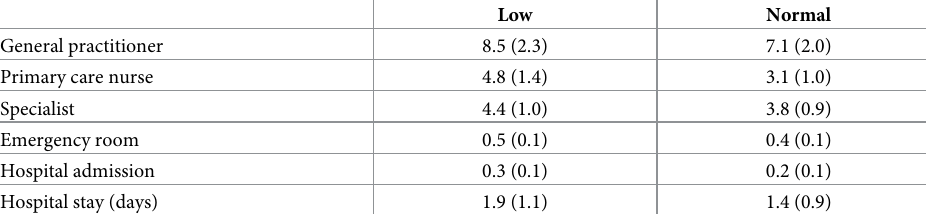
Table 4. Estimates for usability per service by functional performance. Results from the GAMLSS